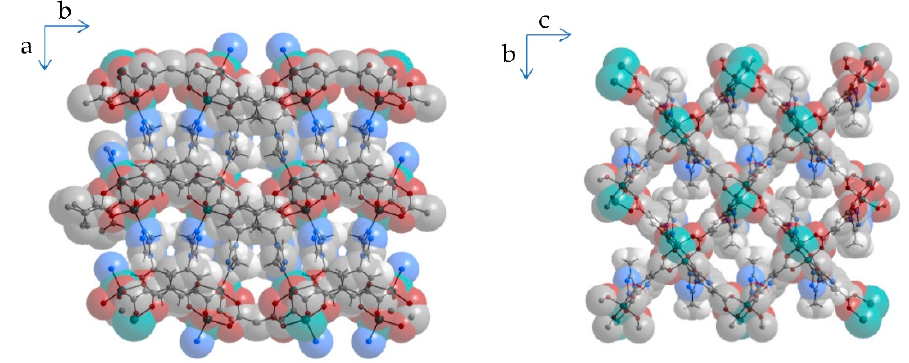
Figure 2. Classical adsorption isotherm in linear ( left ) and logarithmic ( right ) representation for the CO 2 -adsorption at 298 K for Cu-IH-pw, Cu-IHMe-pw, Cu-IHEt-pw, and Cu-IHnPr-pw, showing a decrease in sorptive loading in dependence of the linker size. Graphic adapted from Kobalz et al. [26].